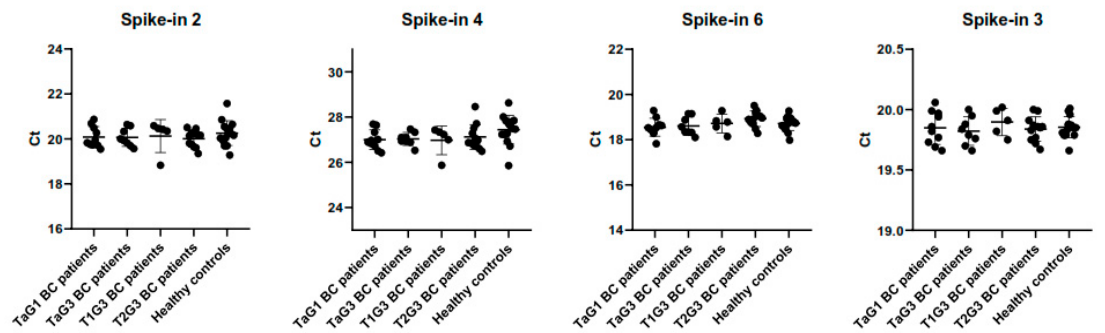
Figure 2. Differences in expression levels of three synthetic spike-in RNAs among BC patients with different stages and grades and healthy controls. Spike-in 2 and spike-in 4 monitor the RNA isolation step, spike-in 6 monitors the retrotranscription efficiency and spike-in 3 functions as inter-plate calibrator. Expression levels are represented as Ct values and error bars represent standard deviation.